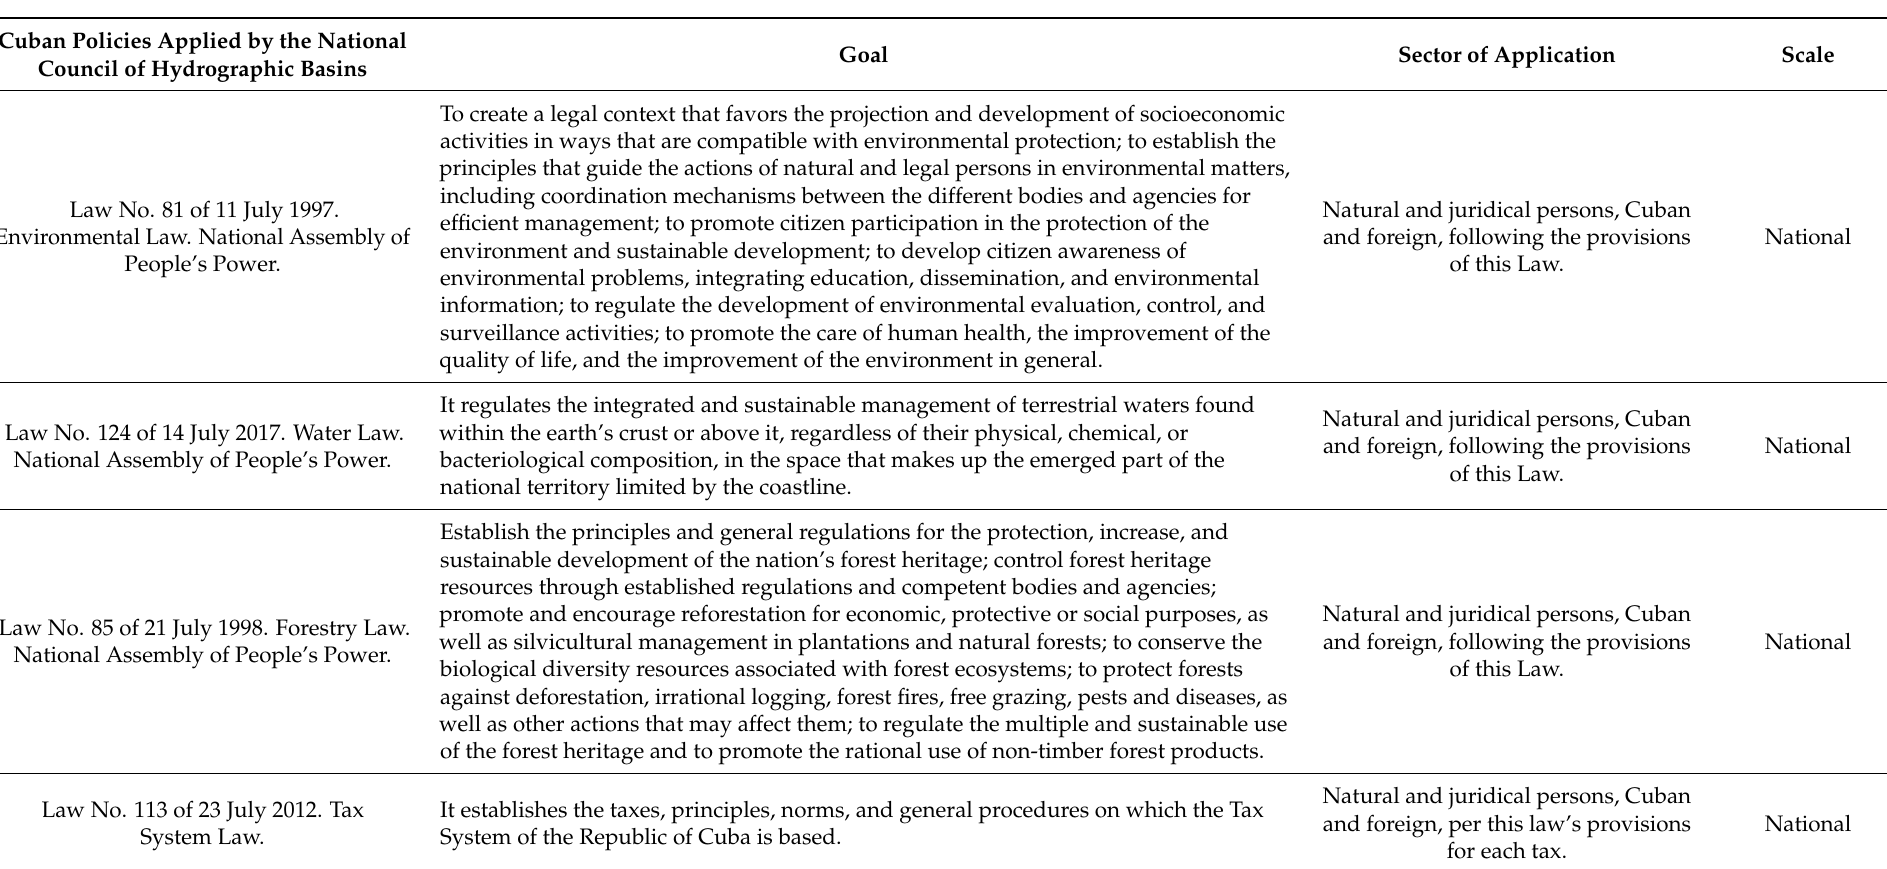
Table A1. Detailed Description of the Goals, Sectors, and Scales of Application of the